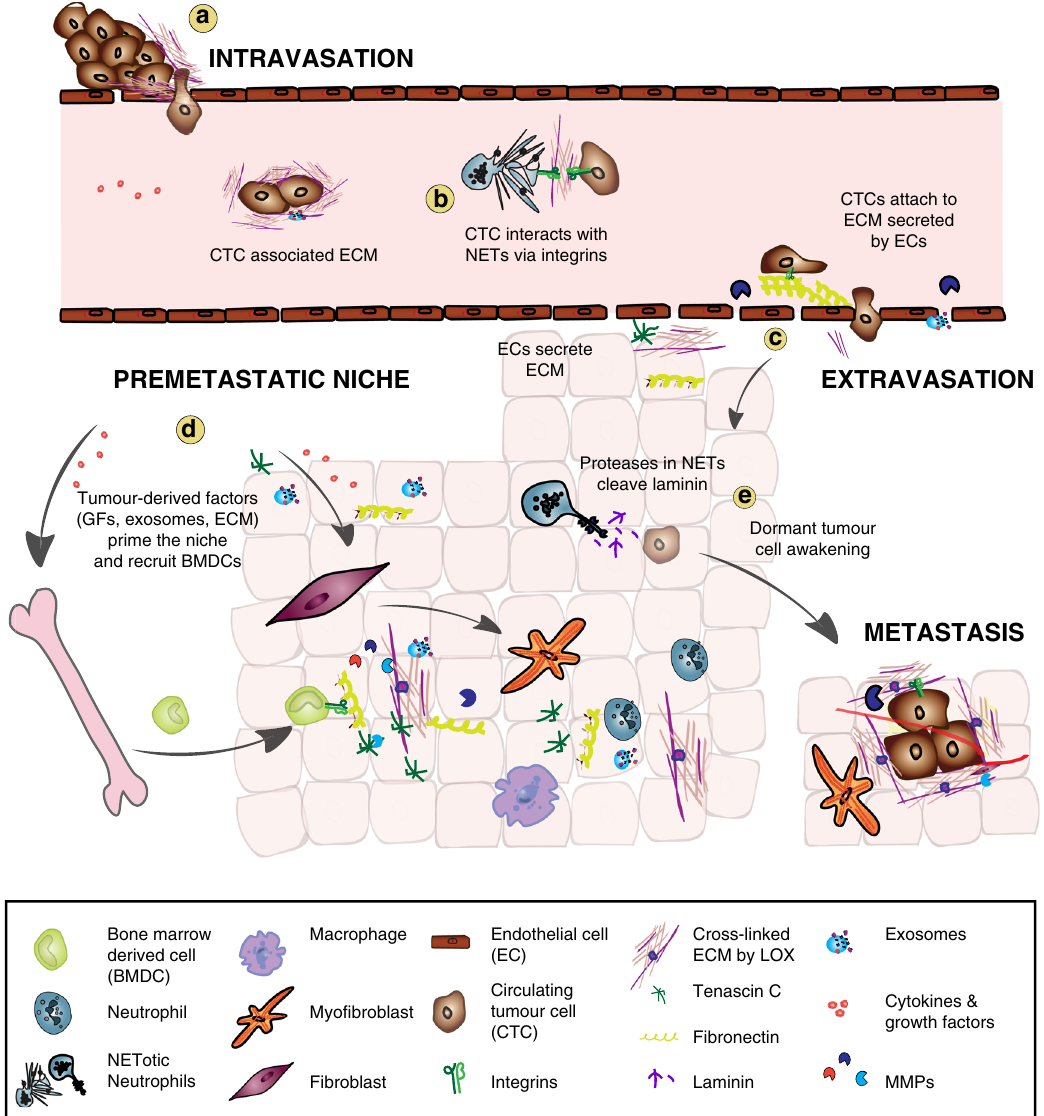
Fig. 4 ECM remodelling in the metastatic cascade. a Angiogenesis and high MMP activity at the primary tumour site lead to a disrupted vasculature that allows tumour cells to intravasate and enter the circulation. Circulating tumour cells (CTCs) may secrete ECM that protects them from